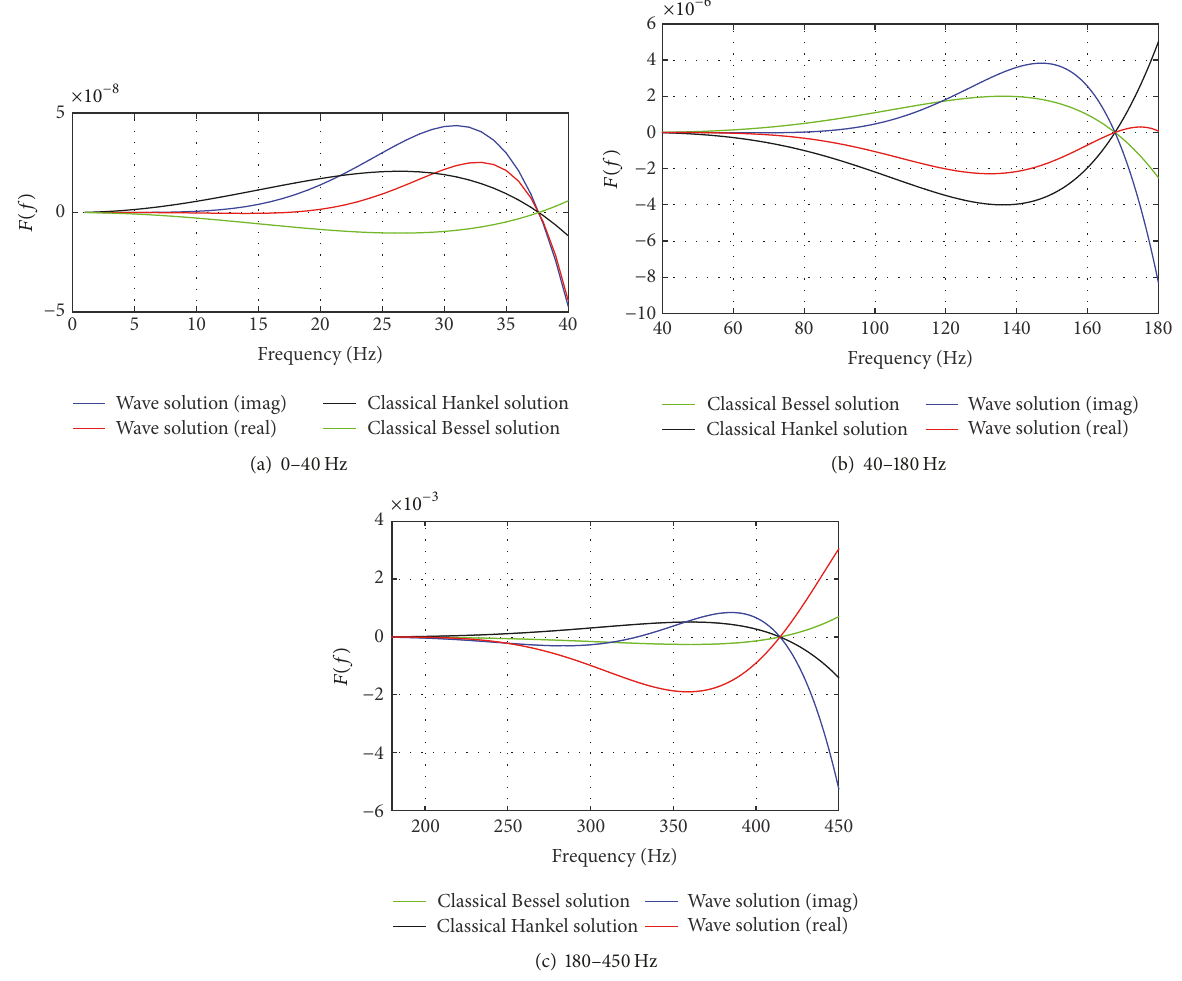
Figure 3: Characteristic curves in the range of 0–450